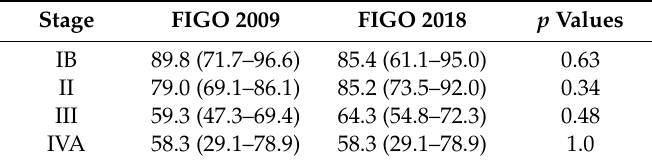
FIGO, International Federation of Gynecology and Obstetrics. Data are % (95% confidence intervals). p values calculated from the log-rank test are shown.